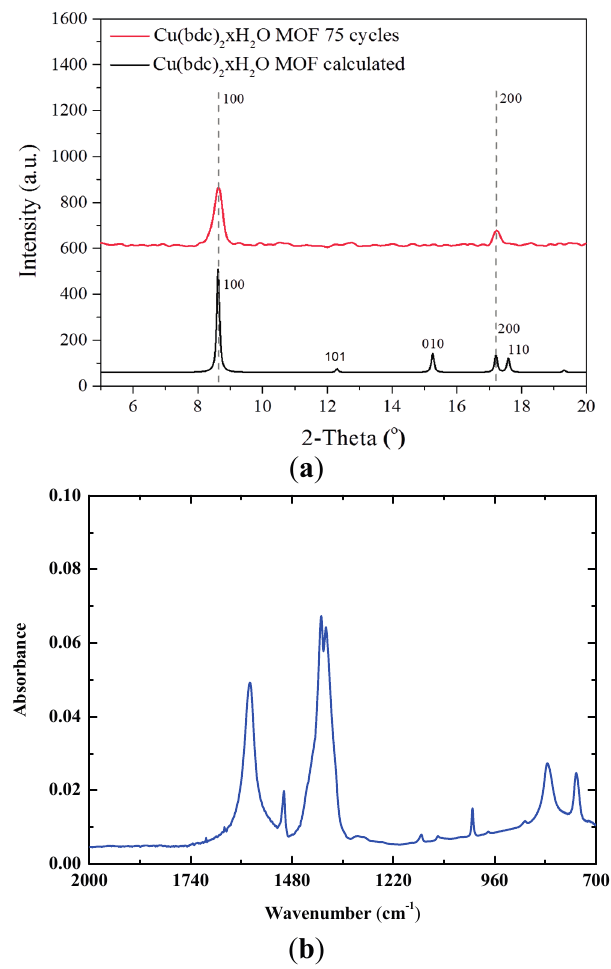
Figure 4. ( a ) XRPD of Cu(BDC)·xH 2 O MOF thin film grown on a sensor chip (red) and its calculated pattern (black); ( b ) IR spectrum of the Cu(BDC)·xH 2 O MOF thin